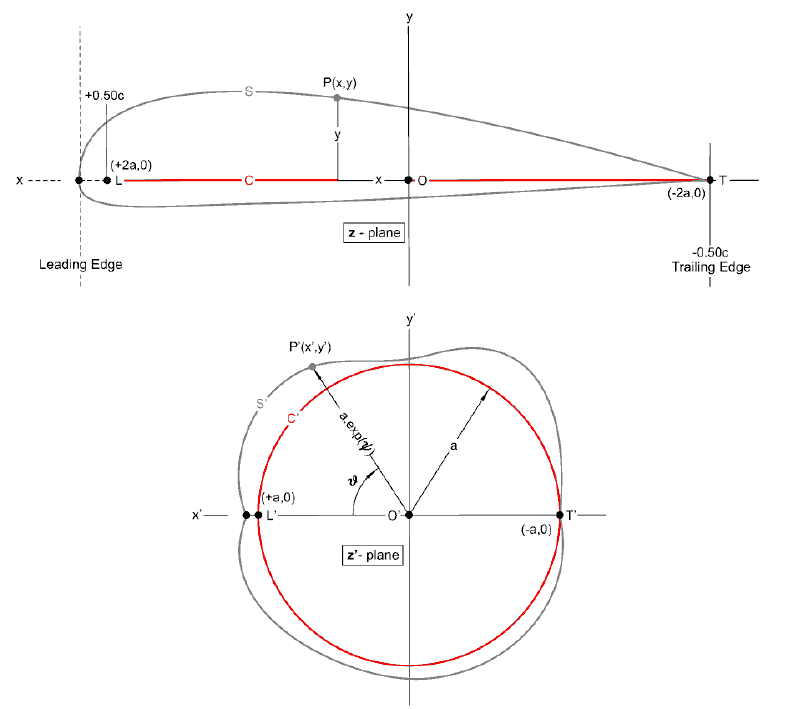
Figure 5. Schematic of the conformal transformation of planes in Theodorsen’s scheme